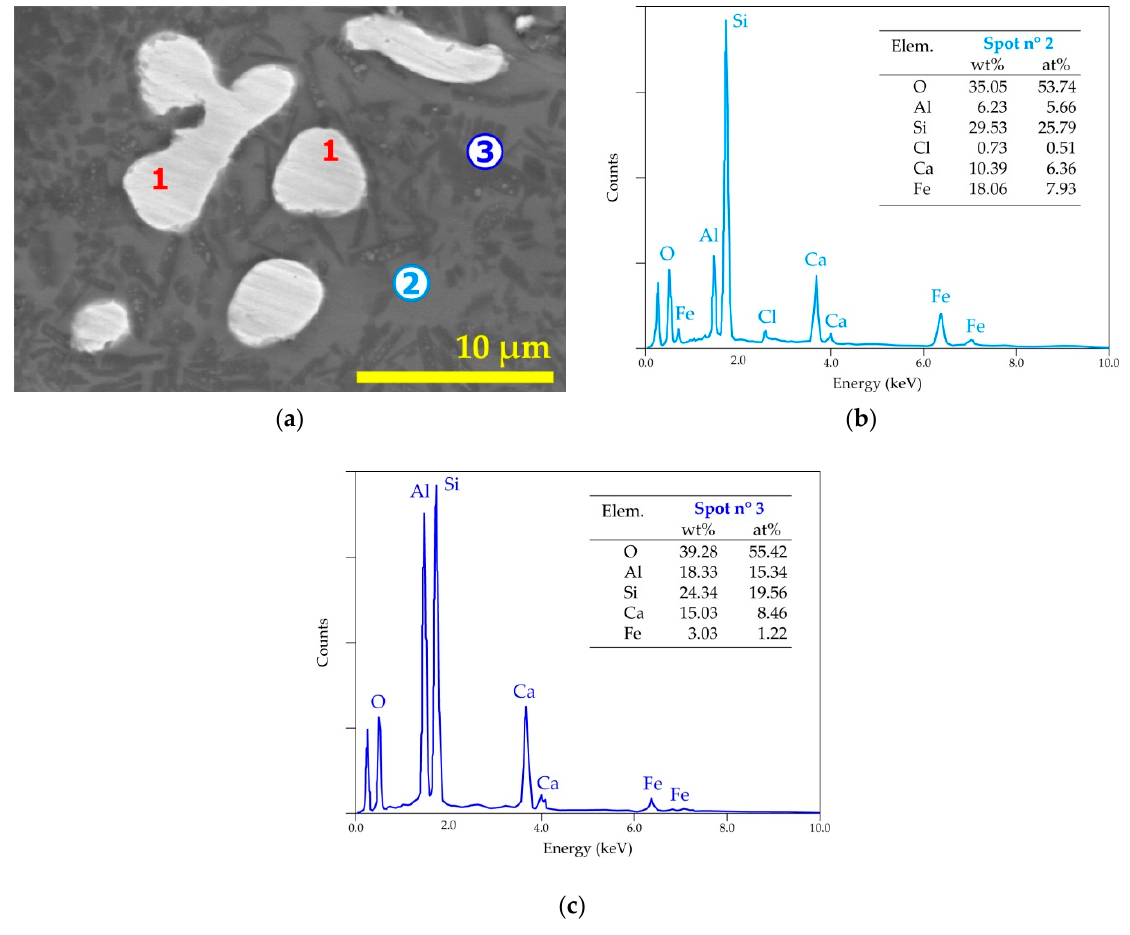
Figure 18. SEM-EDS results of the (hematite + W-PVC + clay) sample treated at 1050 °C for 30 min in the air atmosphere: ( a ) general view (BSE micrograph) of the obtained sample; ( b ) EDS analysis of spot n° 2; and ( c ) EDS analysis of spot n° 3.